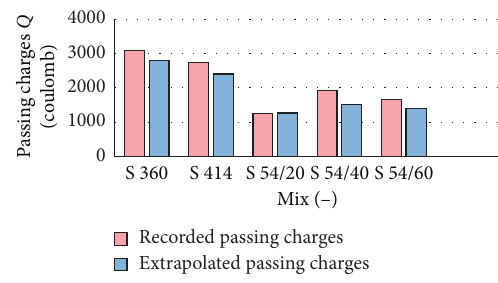
Figure 7: RCPT passing charges Q Table 4: Resistivity, chloride ions penetrability, and corrosion rate.